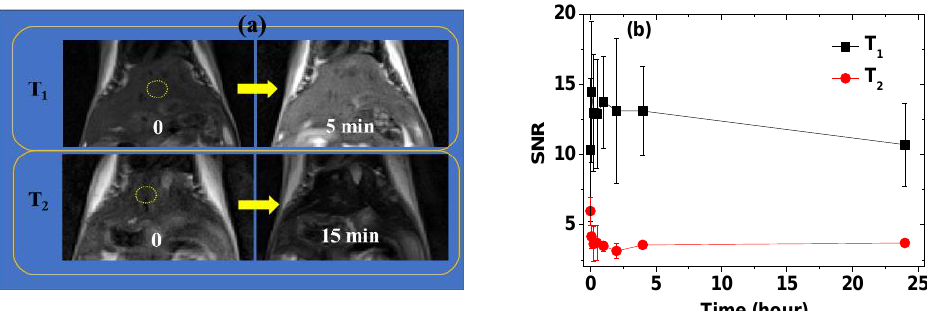
Figure 9. ( a ) T 1 and T 2 MR images of mice liver before (labeled as “0”) and 5 and 15 min after intravenous injection of an aqueous solution of PASA-coated Gd 2 O 3 nanoparticles into mice tails, respectively (N mice = 2 for each modal imaging). ( b ) Plots of SNR-ROIs (labeled as dotted circles) as a function of time.